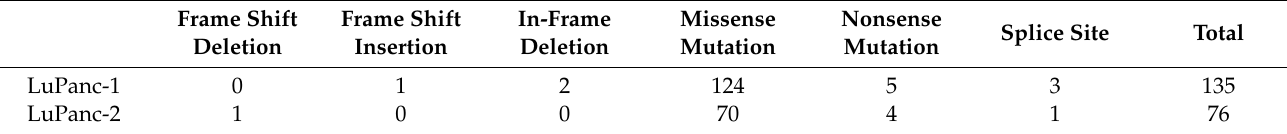
Table 2. Total number of mutations after